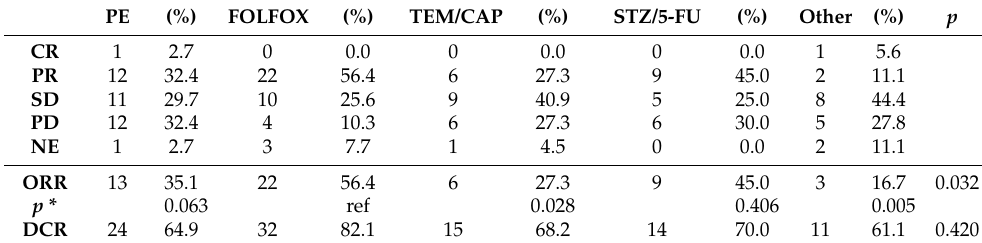
Table 2. Response rates in different first-line treatment